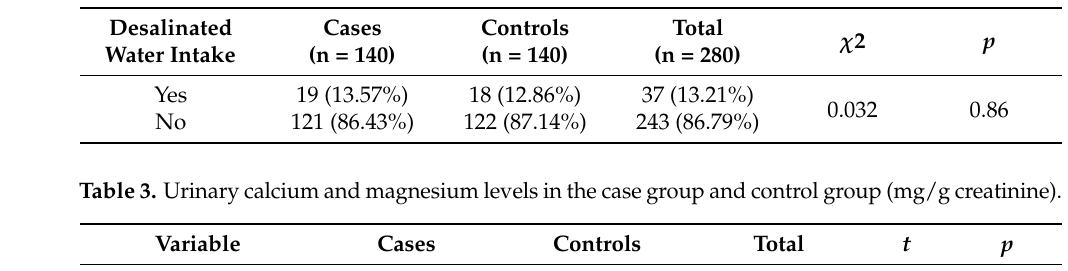
Table 2. Desalinated water intake in the case group and control group.